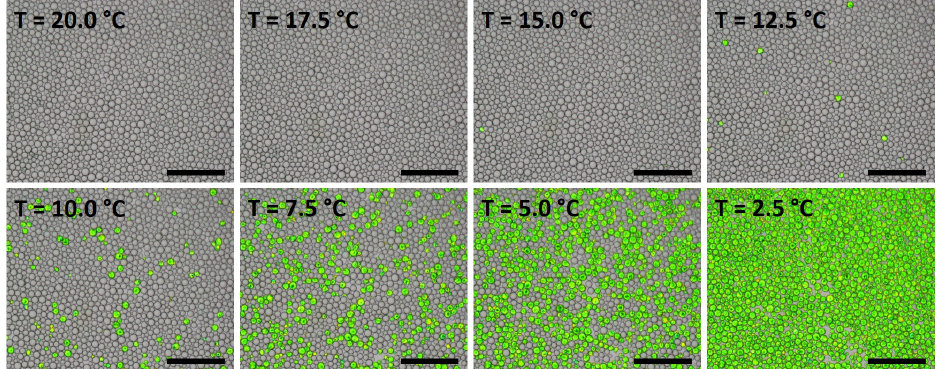
Figure 5. Micrographs of 1 wt % hexadecane in Milli-Q water emulsion stabilized with 1 wt % Tween ® 20. Cooling from 28 to 0 °C with cooling rate of 1 K/min: gray transparent spheres are liquid or supercooled droplets and green opaque spheroids are multi crystalline structures of solidified hexadecane droplets. With decreasing temperature, the number of solidified droplets increases. Length of the scale bar is 200 µm.